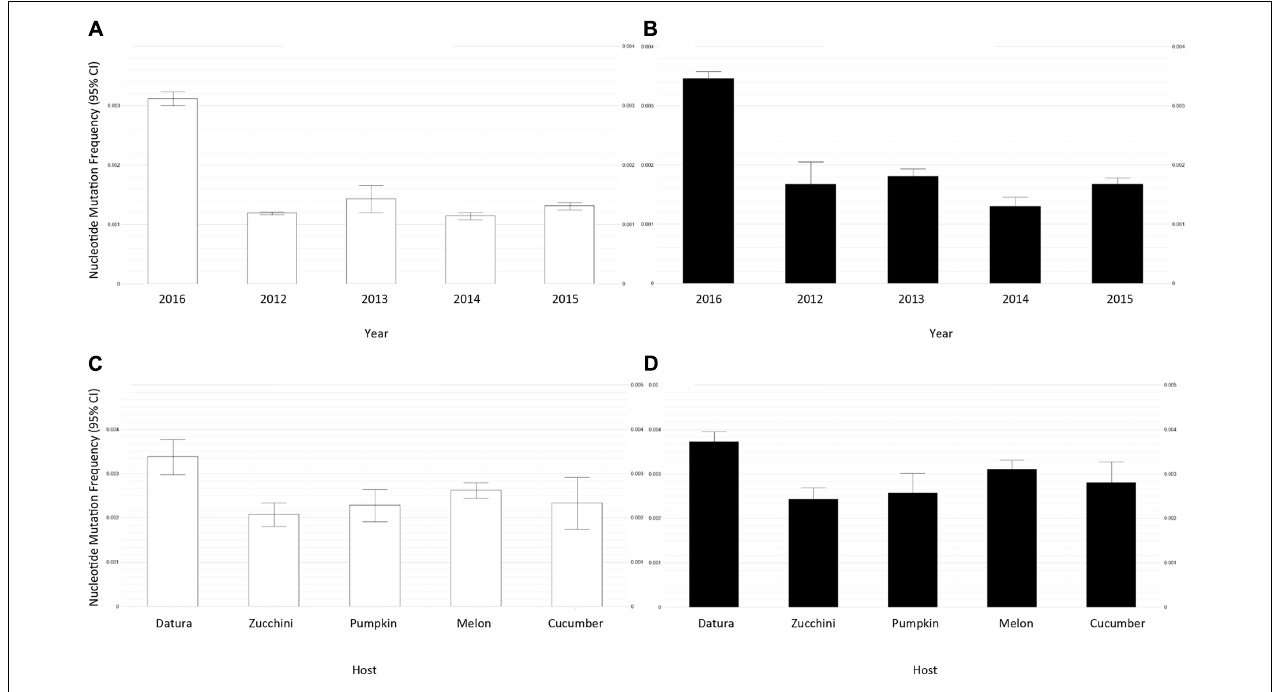
FIGURE 3 | Inference of the heterogeneity within-population of ToLCNDV averaged by the mutation frequency (mutations based on nucleotide substitutions and indels per nucleotide) that was estimated for each viral genomic component A (left, white-bars) and B (right, black-bars), grouping ToLCNDV populations by collection year ( A,B ; 2012 to 2016), and also by infected host ( C,D ; Cucumber, Melon, Pumpkin, Zucchini, and D. stramonium ). Bars represent the mean value with the 95% CI error